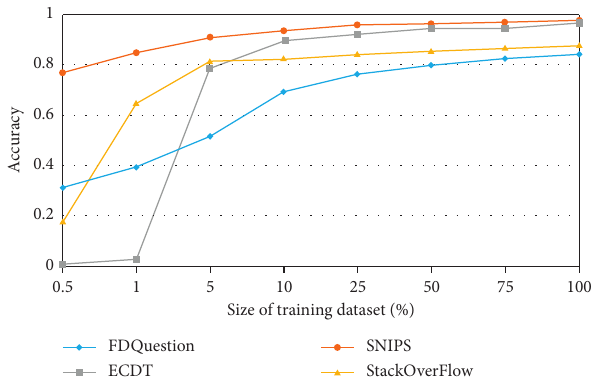
Figure 3: The accuracy of our model with different sizes of training samples on the four